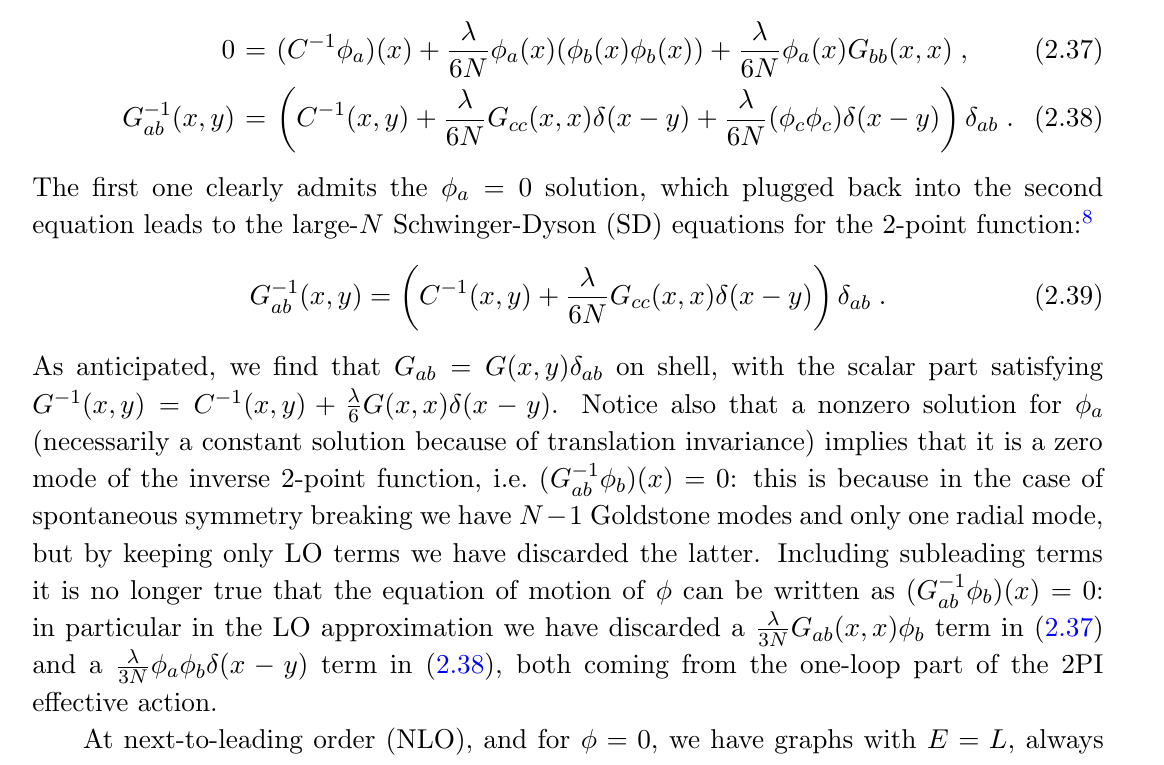
Figure 3 . The leading order contribution of the large- N expansion in the O ( N )